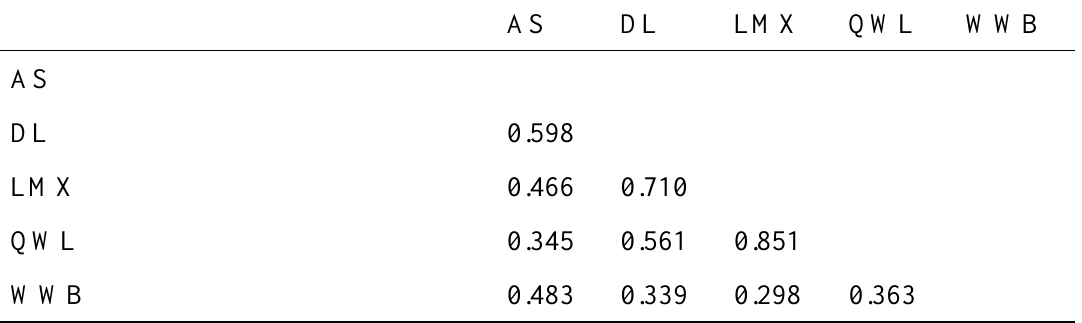
Table 4. Heterotrait-Monotrait Ratio